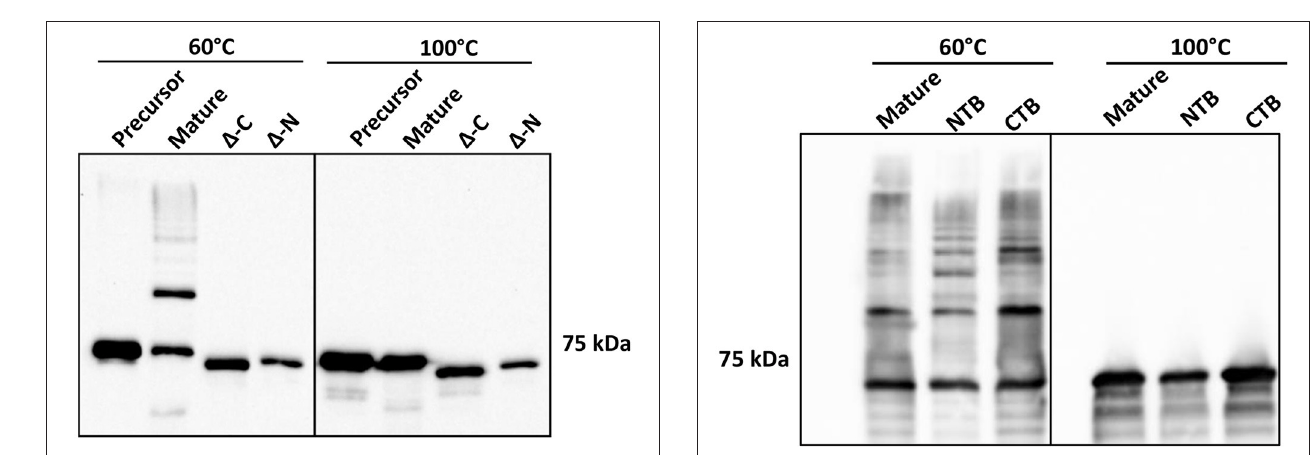
FIGURE 6 | Mfa1 polymerization is unaffected by N-terminal or C-terminal β -strand disruption . Mature Mfa1 protein or derivatives with the N-terminal β -strand proline-substituted (NTB), or the C-terminal β -strand proline substituted (CTB) were treated separately at 60 ◦ or 100 ◦ C prior to SDS-PAGE and immunoblotting with antibodies to Mfa1. Results are representative of 3 biological